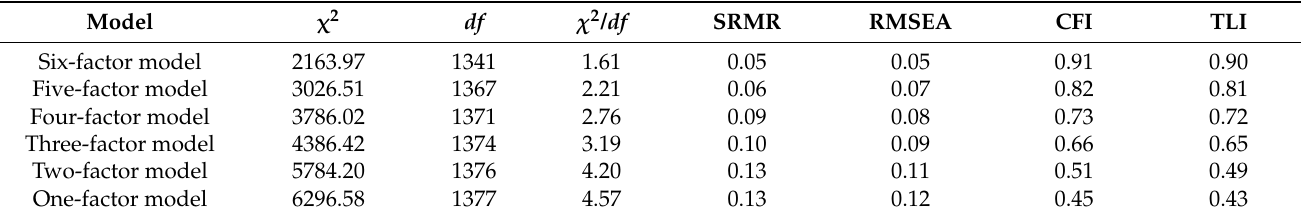
Table 1. Confirmatory factor